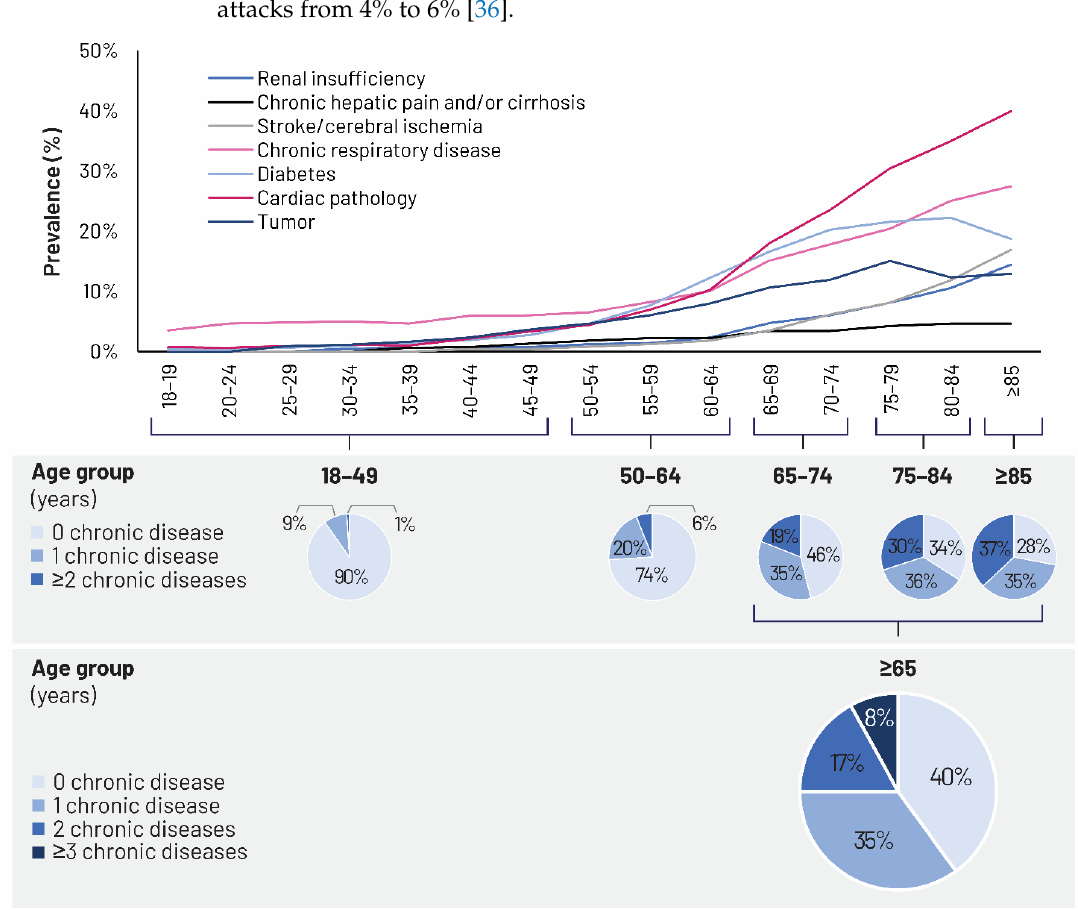
Figure 3. Chronic diseases in the Italian population by age group. Source: Patologie croniche nella popolazione residente in Italia secondo i dati PASSI e PASSI d’Argento (Chronic diseases in the resident population in Italy according to PASSI and PASSI d’Argento data) [35] .